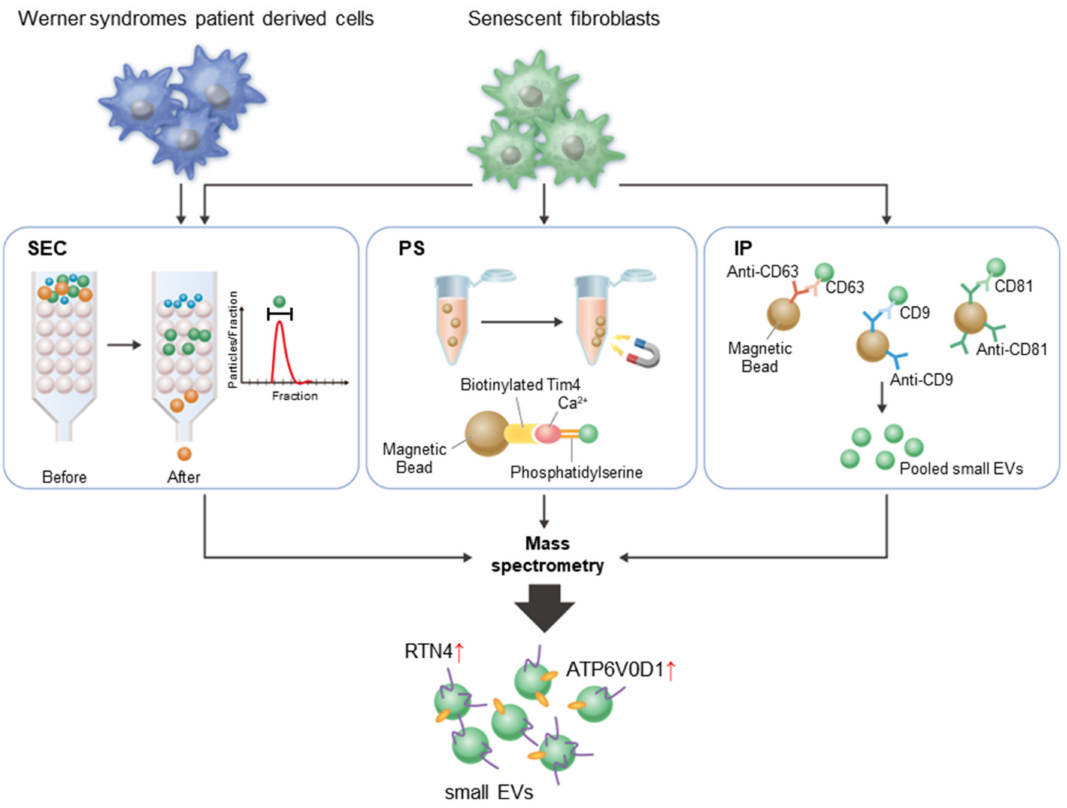
Figure 5. Graphic abstract for this study. sEVs were purified from culture supernatants of senescent fibroblasts using three different purification methods and analyzed by mass spectrometry. sEVs were also purified from culture supernatants of cells derived from patients with Werner syndrome using SEC and analyzed by mass spectrometry. The results of the two mass spectrometry analyses identified ATP6V0D1 and RTN4 as cellular senescence markers enriched in sEVs. SEC: size exclusion chromatography, PS: affinity column for phosphatidylserine, IP: immunoprecipitation with anti-CD9, -CD81, and-CD63 antibodies. Red arrows indicate that ATP6V0D1 and RTN4 are highly expressed in sEVs derived from senescent